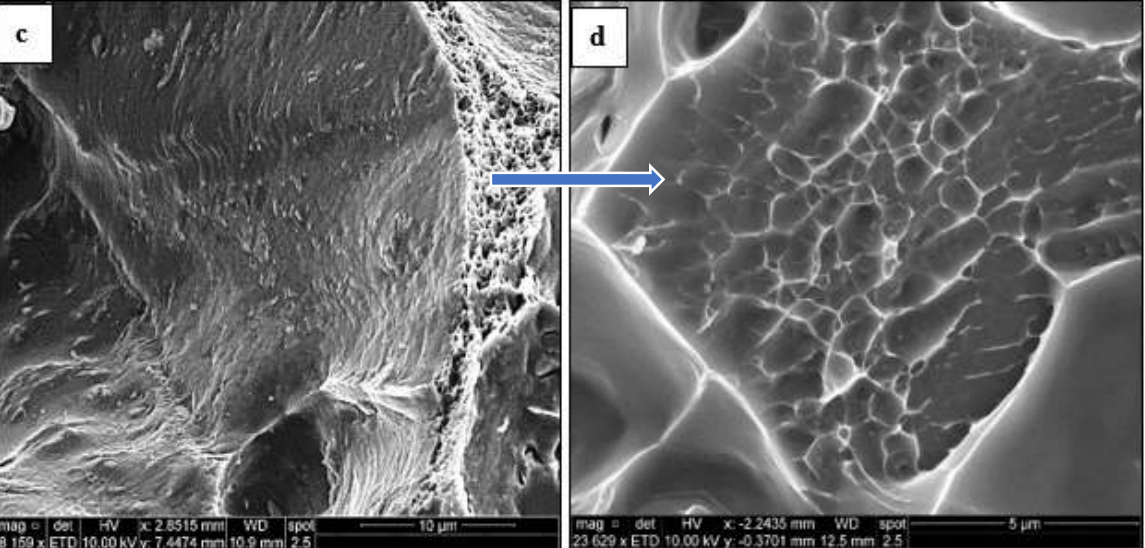
Figure 17. Secondary electron images of the fracture surface of alloy B tested at 250 °C: ( a ) T6 aged